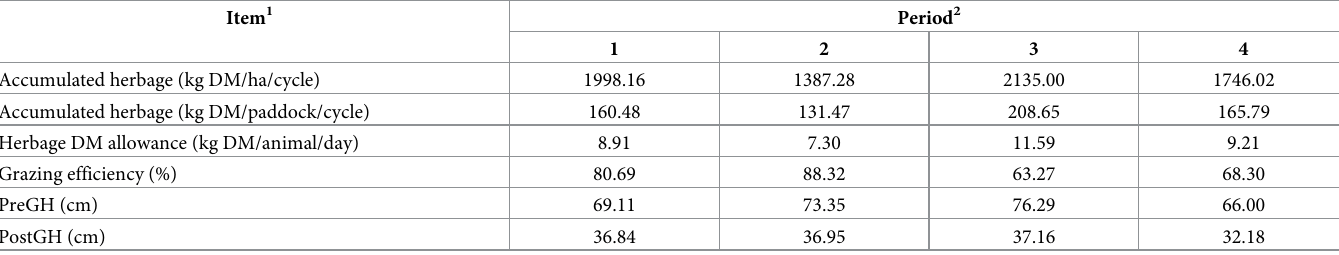
Table 2. Pasture ( Panicum maximum , cv Mombac¸a) characteristics, pre and post-grazing sward height of 18 days (average days of cycle) of grazing activities.